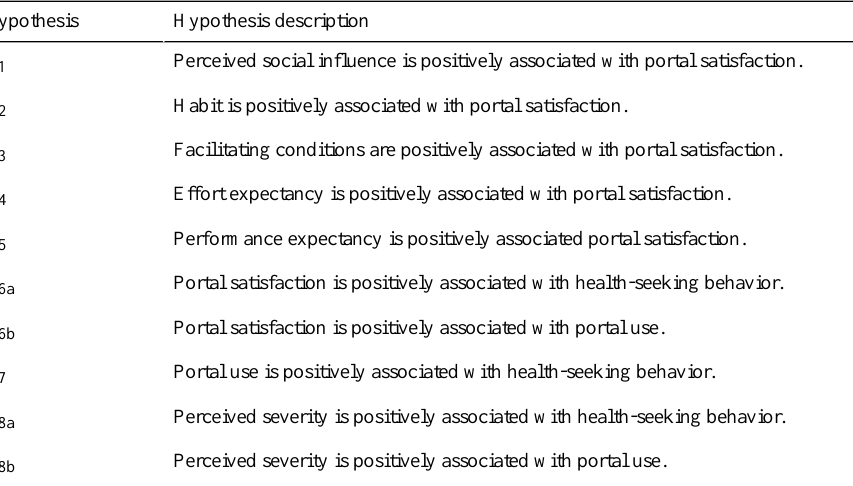
Table 1. Hypotheses